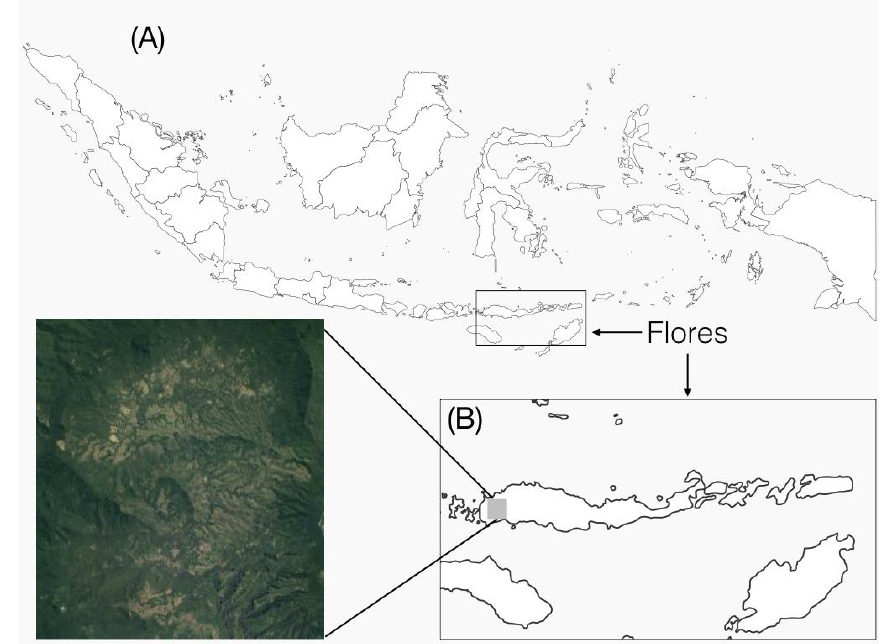
Figure 1. ( A ) A map of Indonesia, ( B ) A map of the Tengara Timur province West Flores, Indonesia. Inset picture of the landscape in West Flores represents the landscape we called Mbeliling.